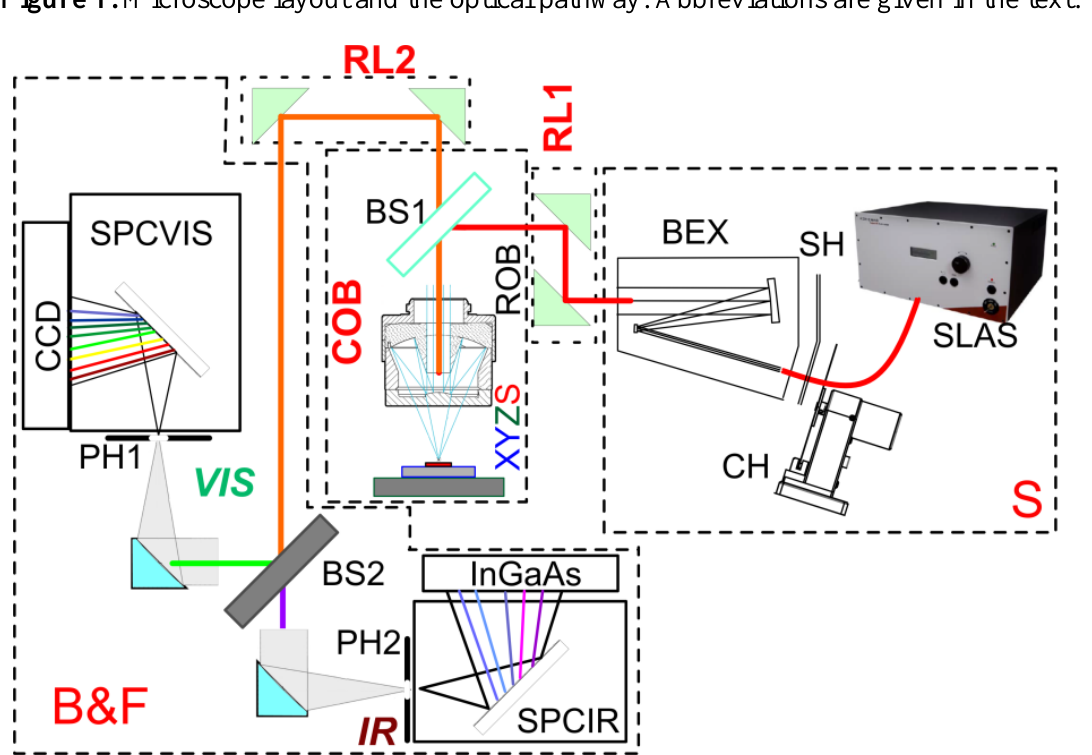
Figure 1. Microscope layout and the optical pathway. Abbreviations are given in the